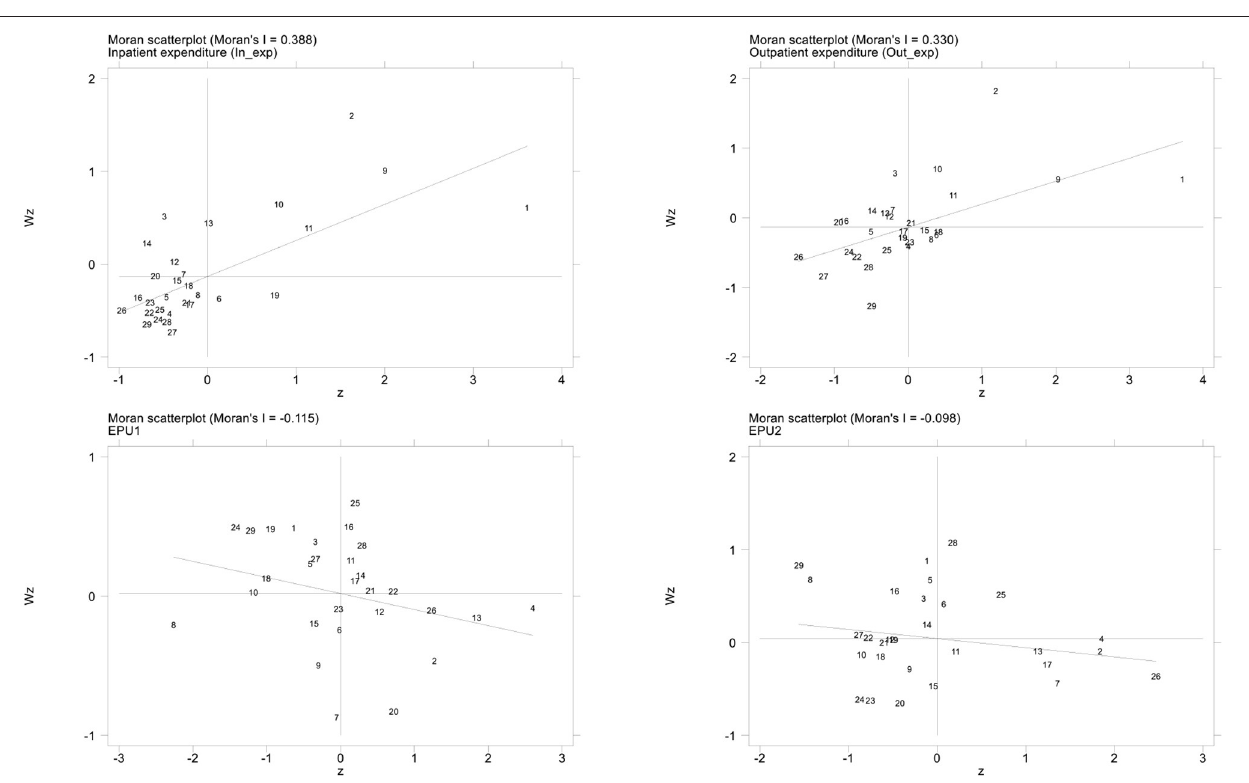
FIGURE 3 | Scatter plot of the local Moran index values for healthcare expenditure and EPU (2017). Horizontal axis represents the observations of the local region, and the vertical axis represents the observations of the adjacent regions; The slope of the regression line in the scatter plot is equal to the global Moran index value.